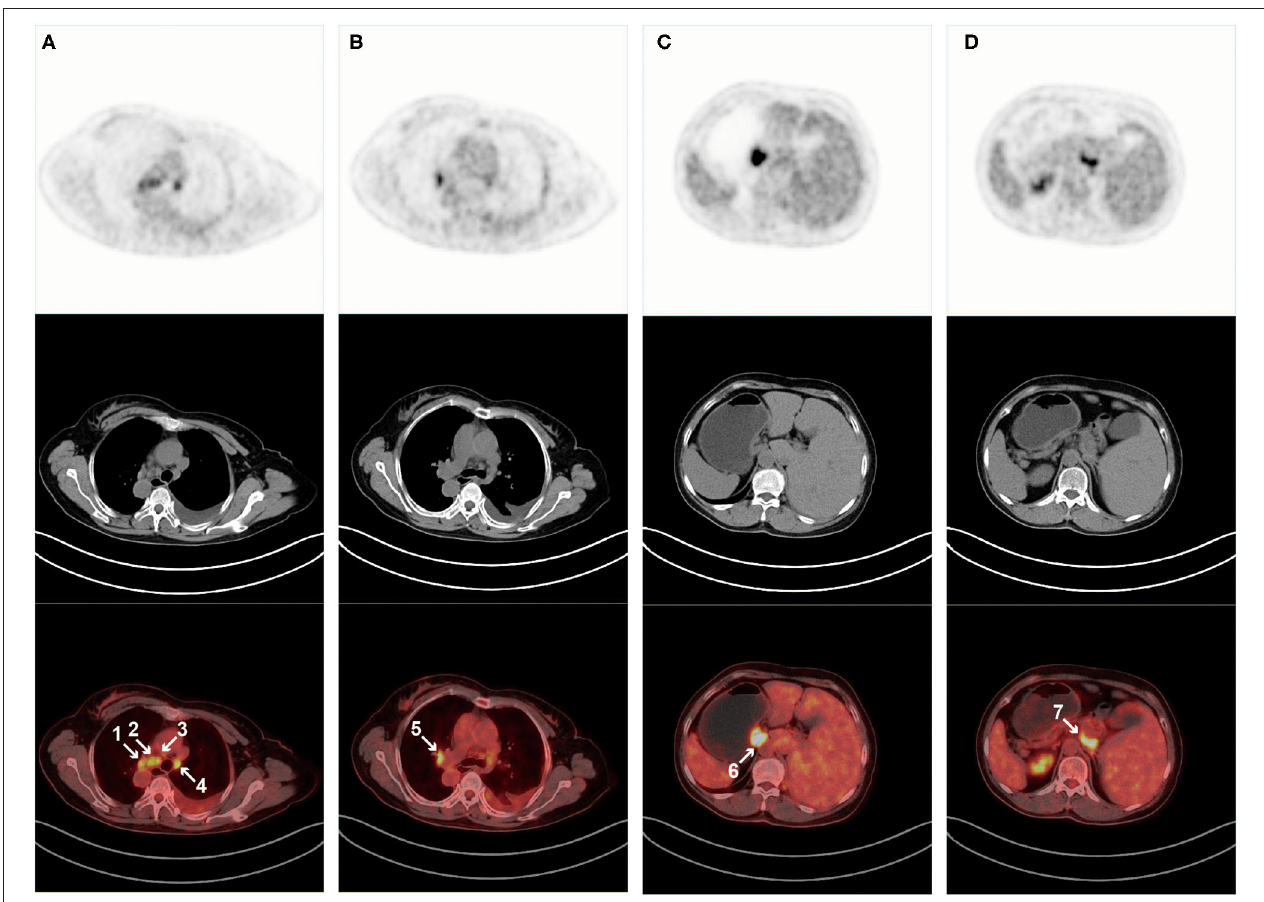
FIGURE 3 | PET/CT scan found that multiple lymph nodes also had high tracer uptake. Axial and coronal PET, CT, and PET/CT fusion images show tracer uptake in the mediastinum (A) Right hilar, (B) Gastric, (C) Liver, and (D) Lymph nodes.